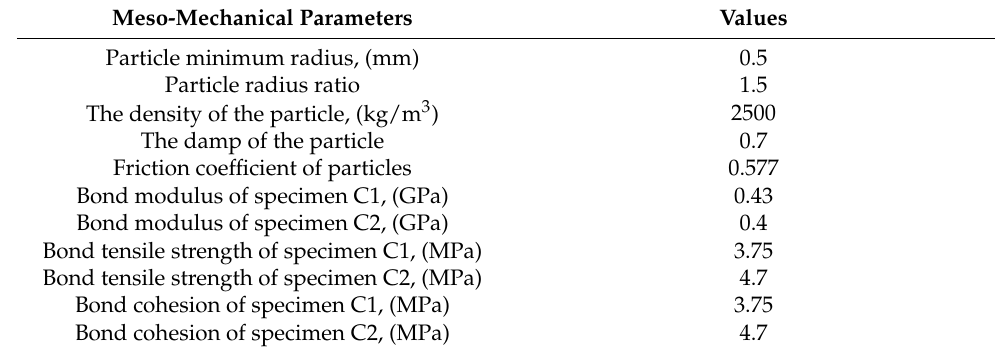
Figure 8. Numerical model of serial coal pillar specimen. Table 3. Meso-Parameters of serial coal pillar specimens with different